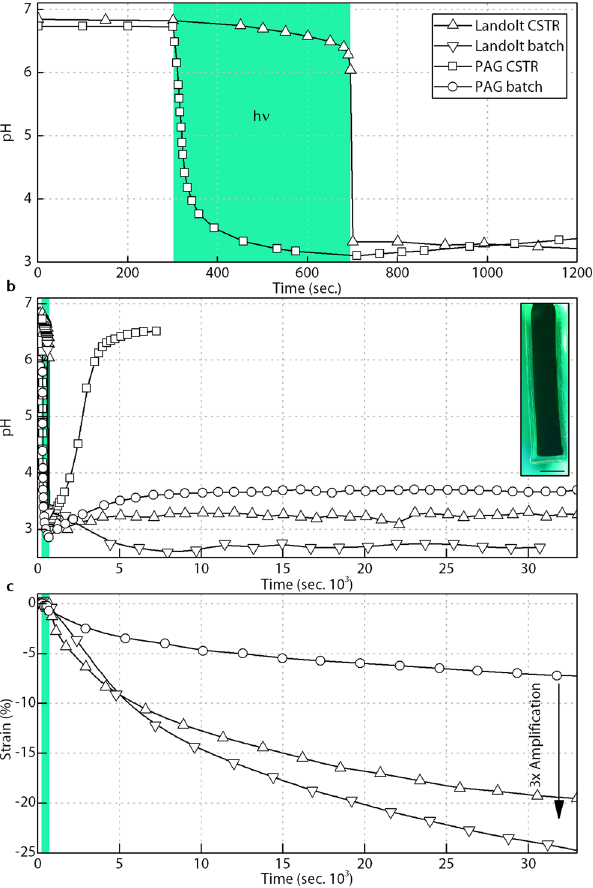
Figure 4. Amplified system response. ( a ) The Landolt CSTR illumination response shows a comparable, albeit delayed pH change to that offered by the PAG alone. ( b ) The use of a large enough hydrogel combined with post illumination PAG and Landolt batch operation, where the CSTR pumps are turned off, reveals the role of pH buffering. ( c ) The resulting three-fold actuation strain when comparing the PAG batch result (no diffusion rate restrictions) to either the Landolt system under CSTR or batch operation (Supplementary Movie 2). The use of larger hydrogels does result in part of the hydrogel’s interior being trapped in the low pH state, as shown by the dark region in the photo inset of the hydrogel artificial muscle, likely limiting the resulting actuation and indicating that further refinement of the system could yield even larger amplification values. Here we no longer employ the black tracking sphere as per the inset of Fig. 3, as the edges of the non-porous gel used remain visible in all states. Scale bar 5